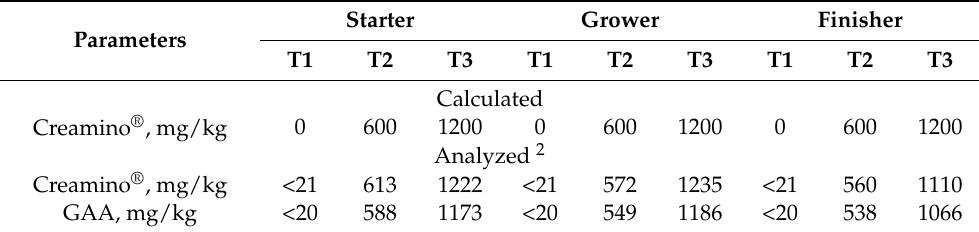
Table 2. Analyzed guanidinoacetic acid content of the dietary treatments 1 . Starter Grower Finisher Parameters T1 T2 T3 Calculated Creamino ® , mg/kg 0 600 1200 0 600 1200 1200 Analyzed 2